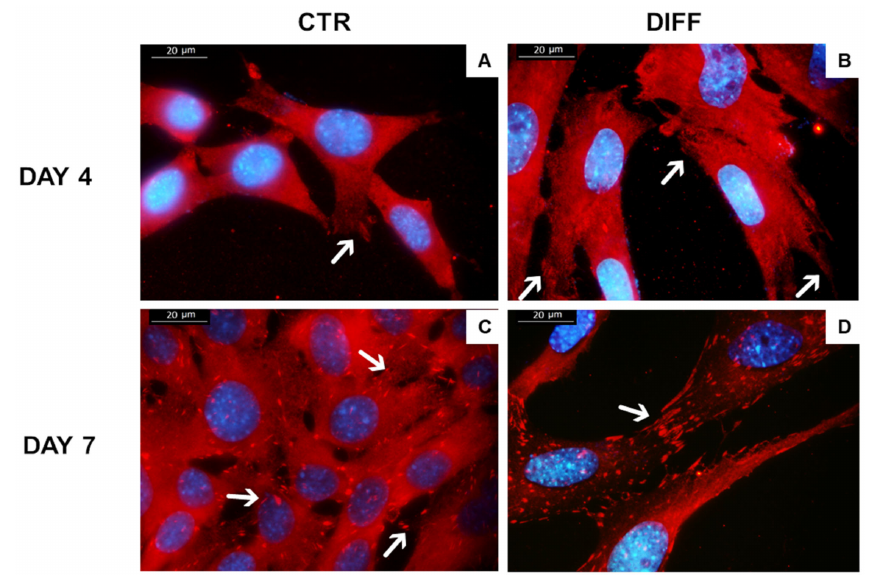
Figure 5. H9c2 cell morphology obtained by vinculin (red) staining. Images represent control cells at 4 ( A ) and 7 ( C ) days and differentiated cells at 4 ( B ) and 7 ( D ) days. Images are representative of all of the results obtained in the different experimental conditions. White arrow indicates vinculin in focal adhesions. Scale bar: 20 µ